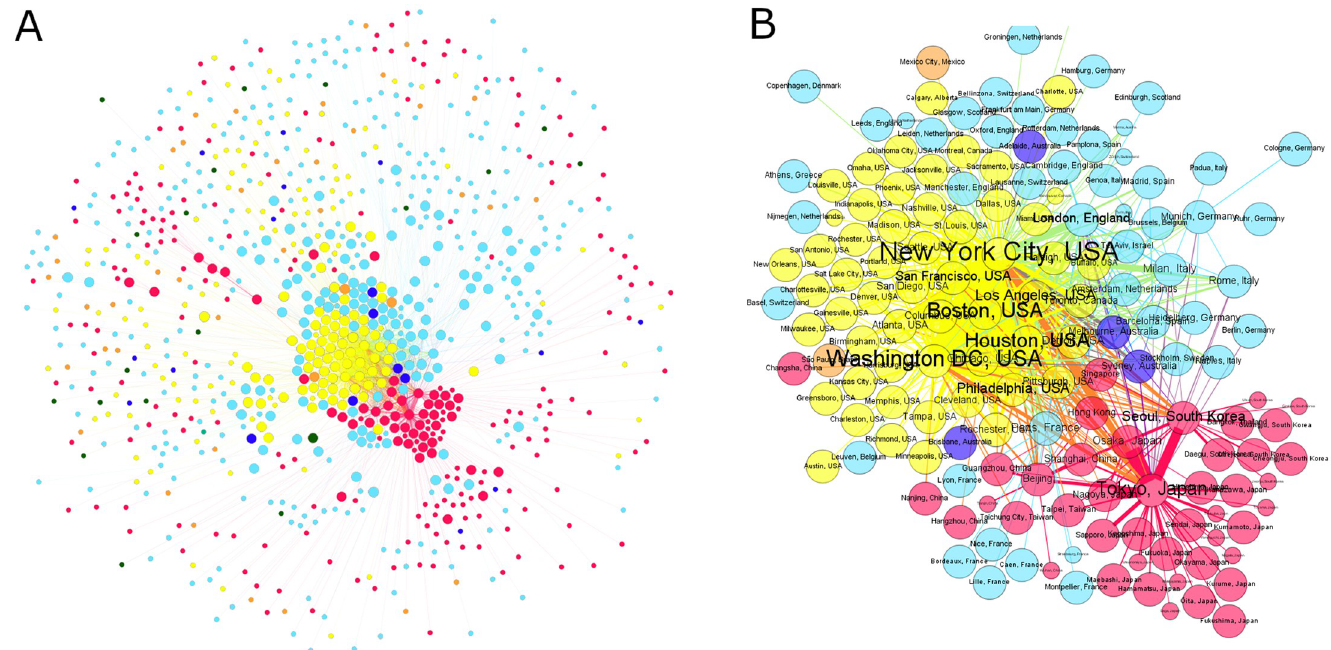
Fig 1. City-level co-editor network of oncology journals. (A) Visualization of the entire network. We keep all cities in the network by applying the maximum spanning method. Then, the strongest 10% of edges are added to this network to illustrate the density of the network core. Large nodes are part of the network core, and small nodes are in the network periphery (described in the Methods section). Nodes are colored by continents: Yellow—Northern America, red—Asia, light blue—Europe, dark blue—Australia and Oceania, orange—Latin America, black—Africa. (B) The asymmetric sub-core structure of the co-editor network. Node labels are proportional to the number of resident editors in cities. Edge thickness is proportional to the number of journals co-edited between the pairs of cities.